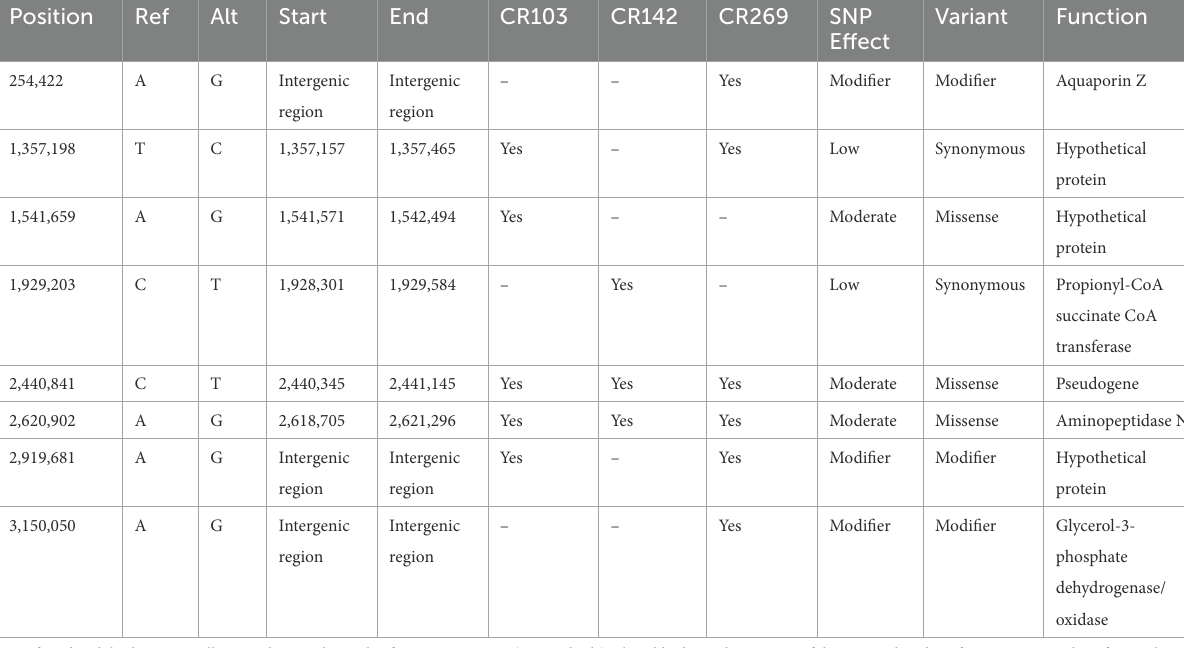
TABLE 3 Predicted impact and characteristics of the SNPs present in the M . brumae strains compared to the M . brumae reference genome.